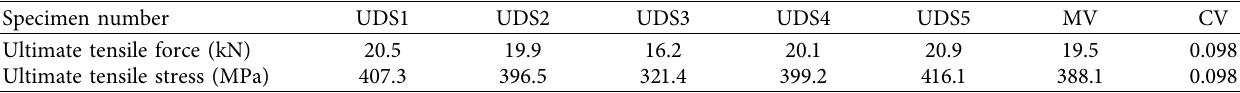
Table 4: Ultimate tensile forces and stresses of CFRP rods anchored by traditional bond anchors. Specimen number UDS1 UDS2 UDS3